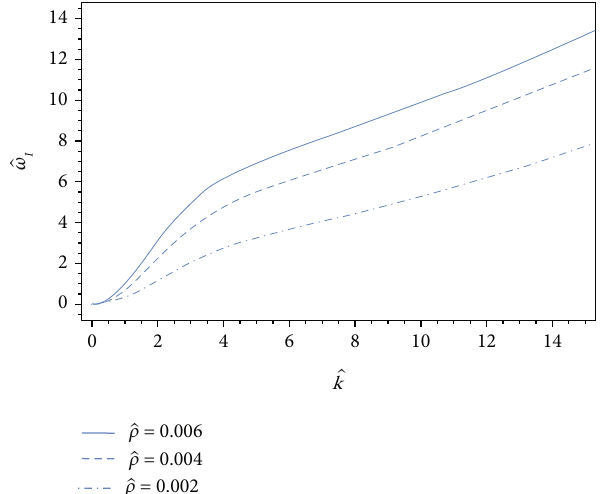
Figure 3: In fl uence of density ratio of fl uids on growth rate curves at Oh = 100 , b μ ′ = 0 : 6 , b μ = 0 : 4 , L = 0 : 3 , = 6 , and ̂ H = 20 . Ce 1